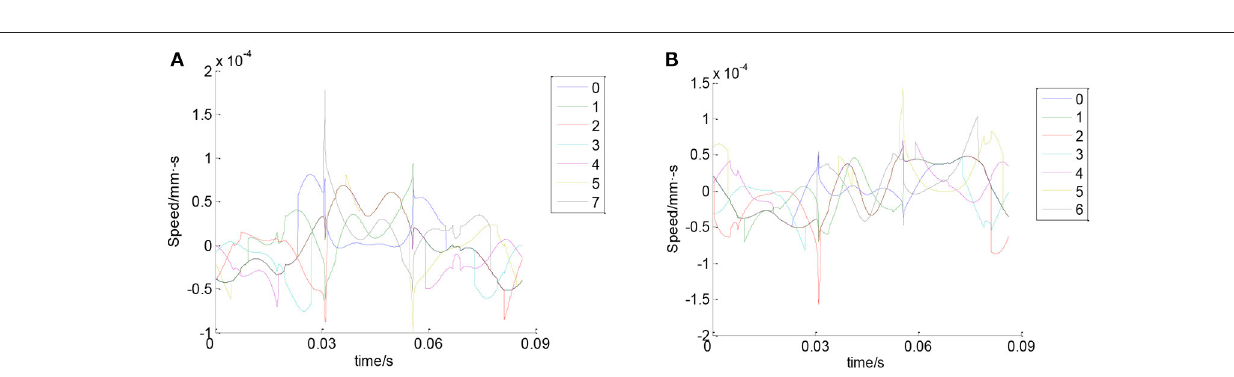
FIGURE 11 | Velocity of the balls. (A) Velocity of the balls in X direction. (B) Velocity of the balls in Y direction.